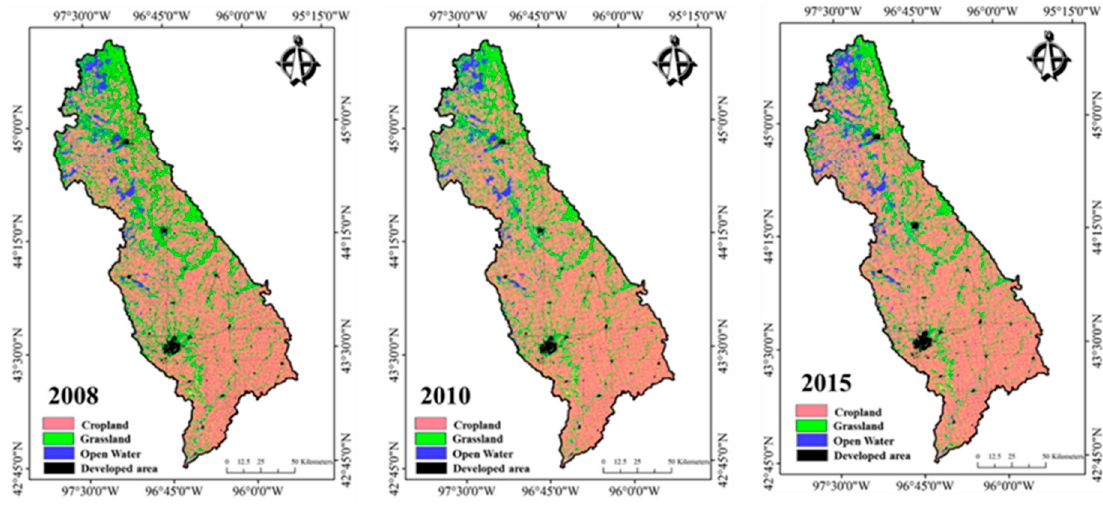
Figure 2. The spatial distribution of rain gauge stations, soil samples, DEM and land use maps for 2008, 2010 and 2015 in the watershed located in Northern Great Plains of USA.